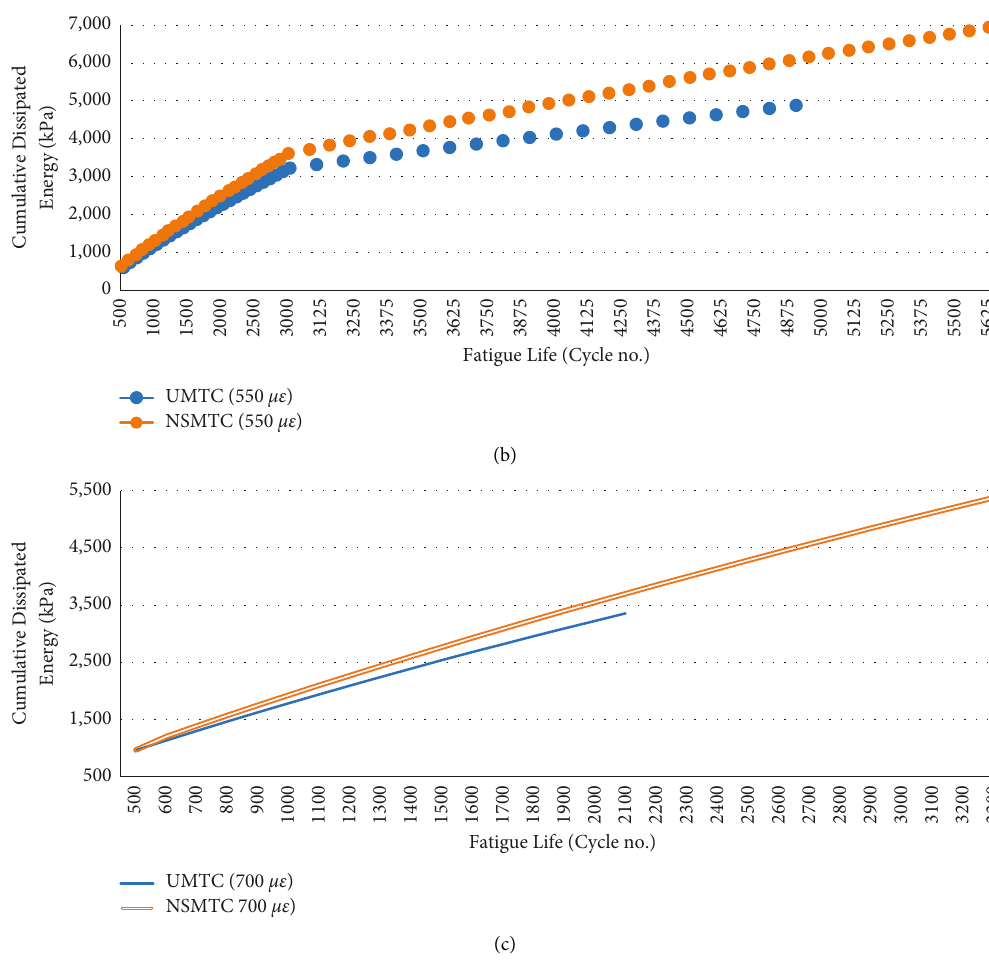
Figure 4: Changes in cumulative dissipated energy against fatigue life of UMTC and NSMTC specimens at the strain levels of (a) 400, (b) 550, and (c) 700 με .